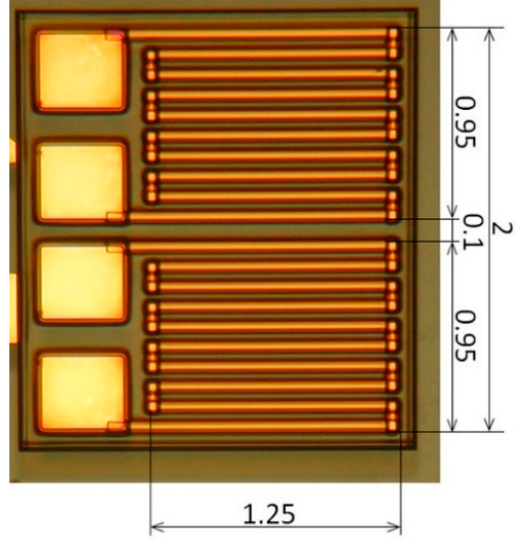
Figure 28. Photograph of the meander shaped differential sensor.